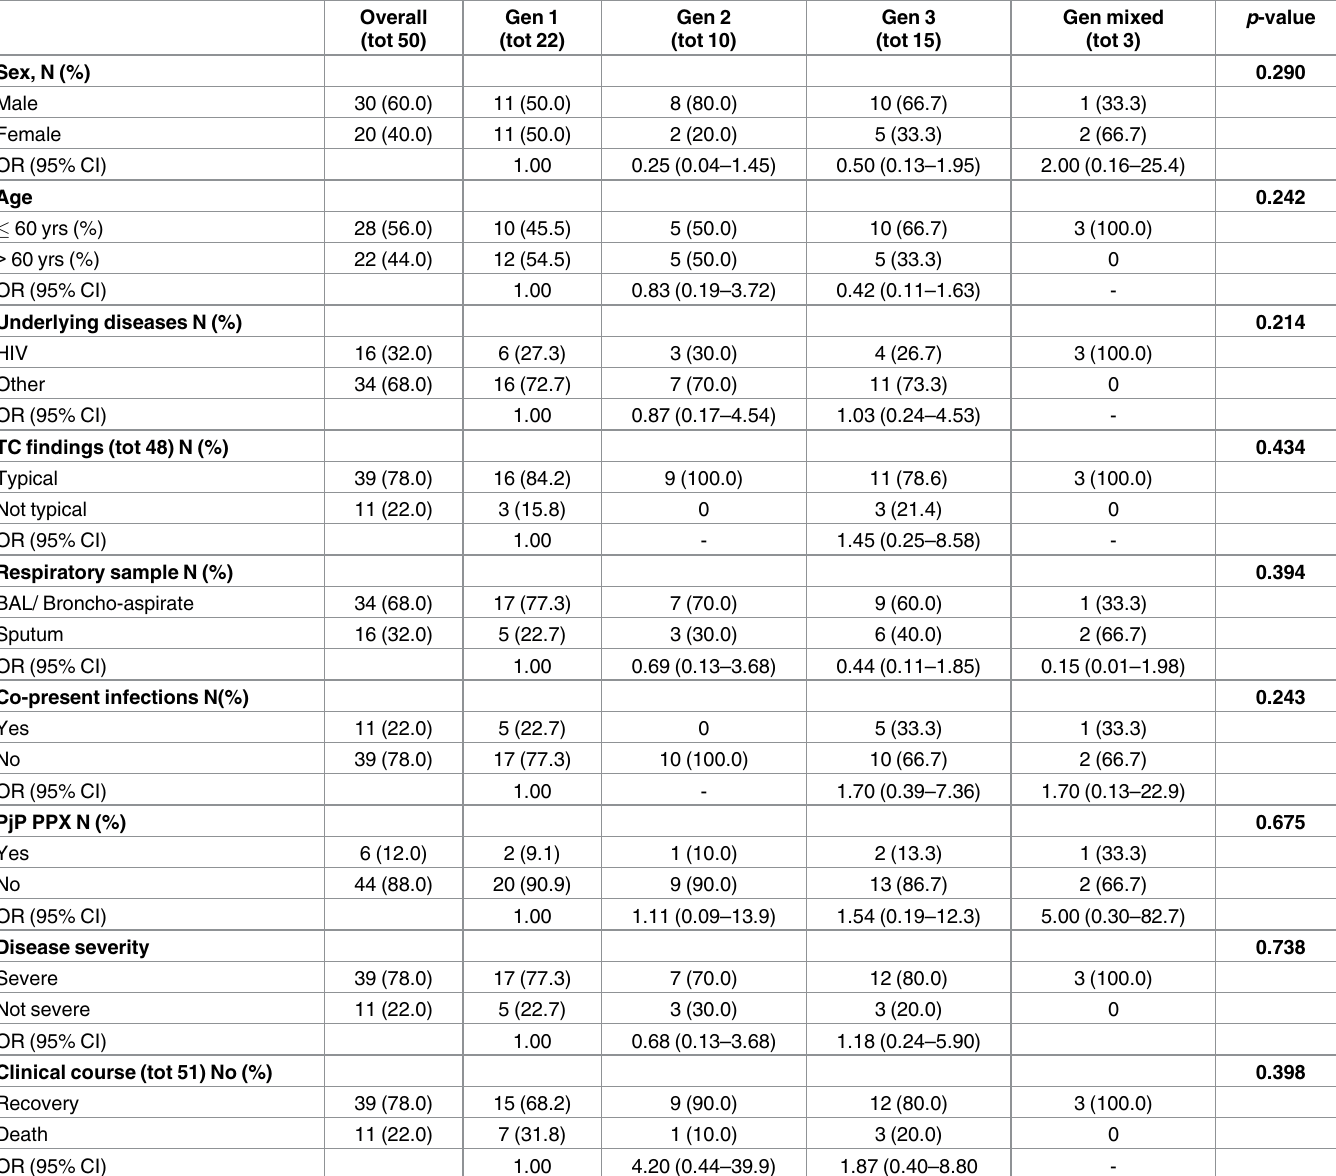
Table 5. Genotype characteristics of 50 patients affected by